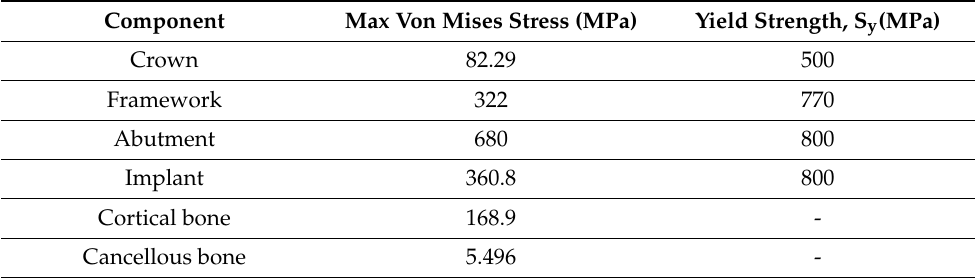
Figure 11. Stress distribution in the cancellous bone. Table 3. Maximum Von Mises